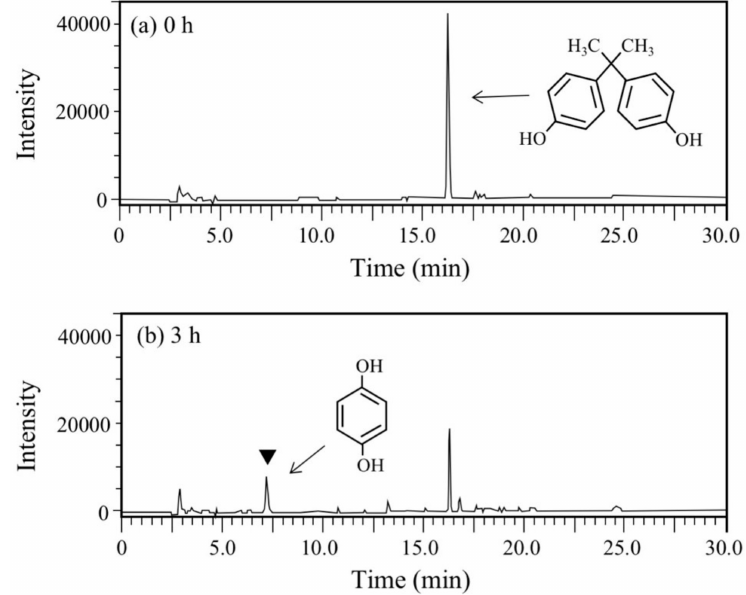
Figure 3. Chromatograms from HPLC analysis of the cell suspension samples of P. putida